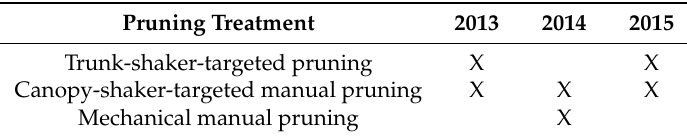
Table 1. Pruning schedule in both olive groves. X means the year in which pruning was applied for each